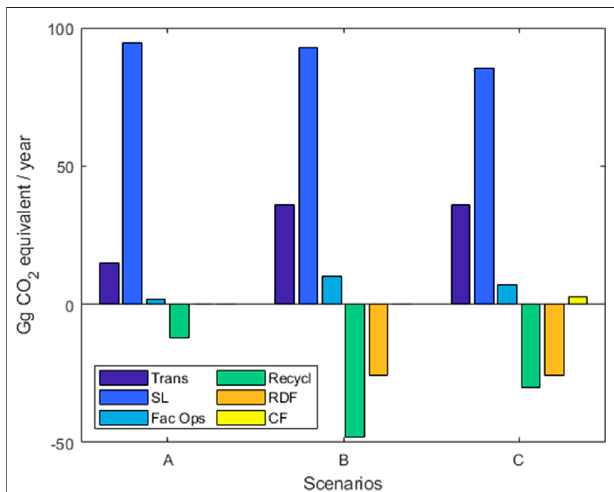
FIGURE 4 | Total GHG contributions per scenario. Transport (Trans), Sanitary land fi ll (SL), Facilities operations (Fac Ops), Savings due to recycling of recoverable materials (Recycl), Savings due to RDF co-processing in cement kiln (RDF), Composting facilities (CF).